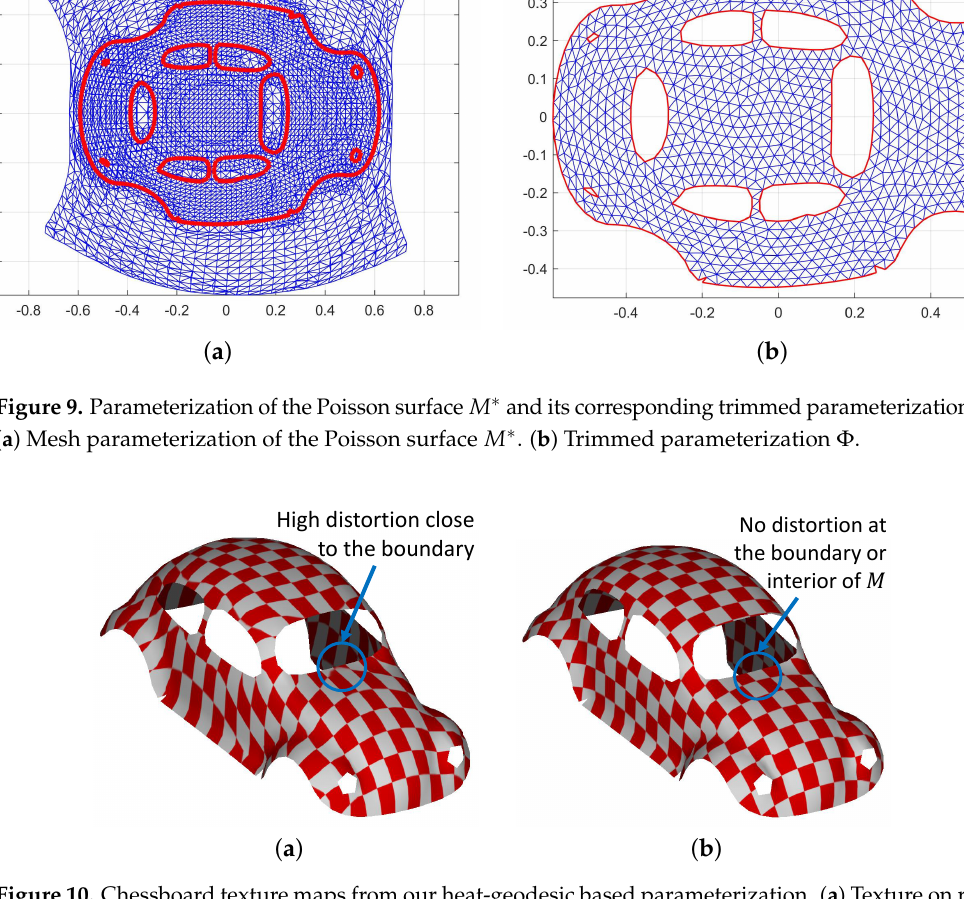
Figure 10. Chessboard texture maps from our heat-geodesic based parameterization. ( a ) Texture on raw mesh M , distorted at holes and boundary concavities. ( b ) Texture using underlying Poisson surface M ∗ ,